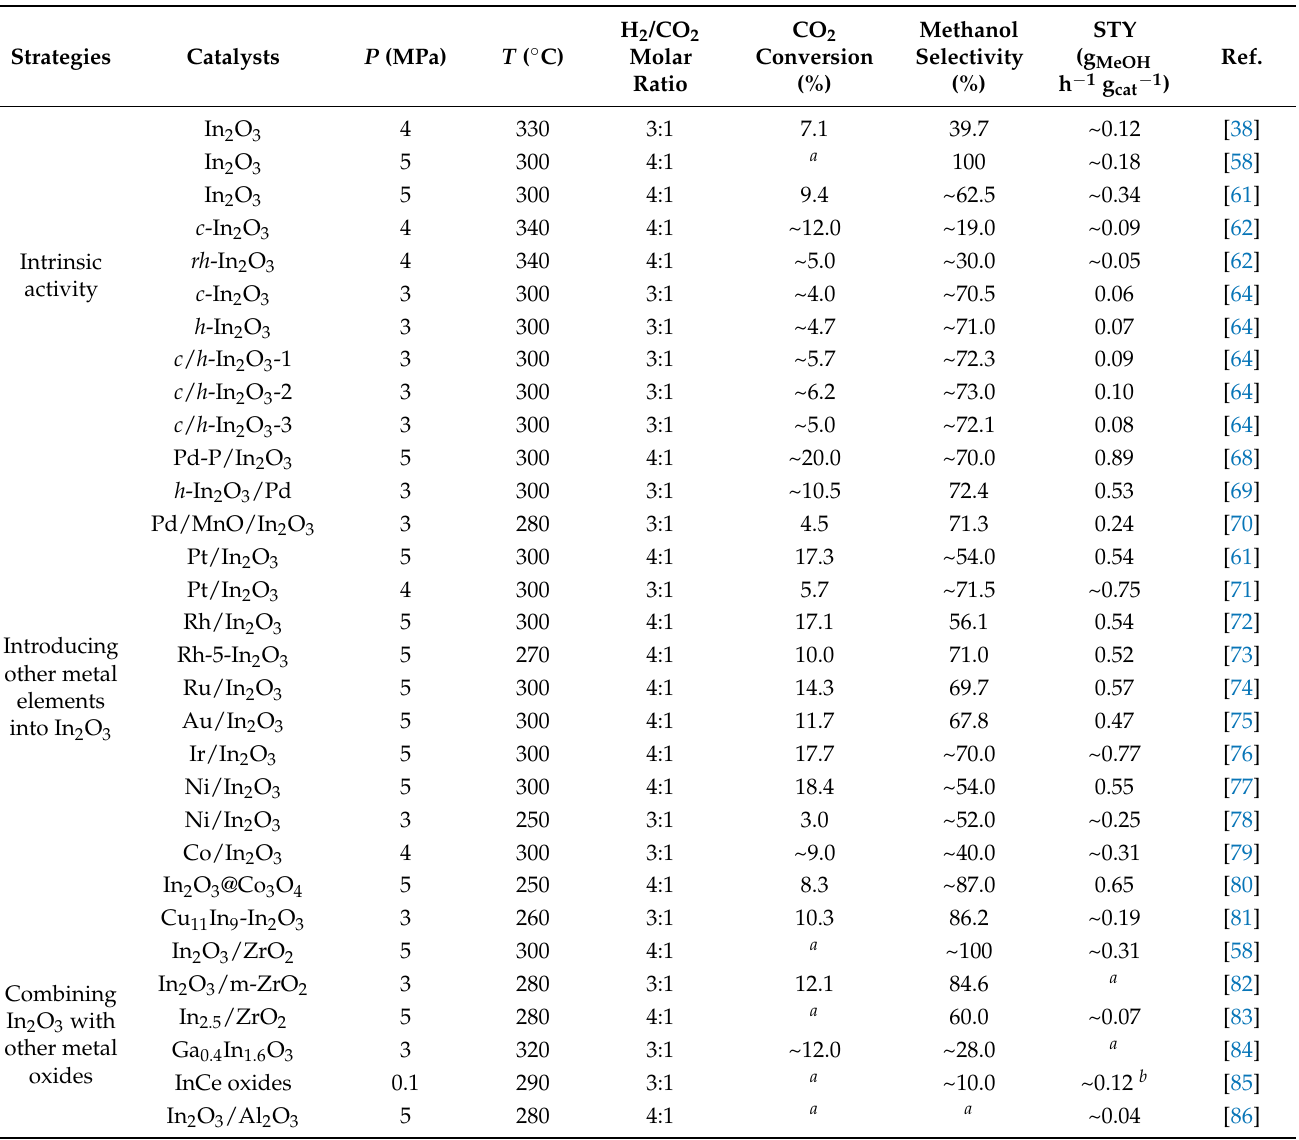
Table 1. Catalytic performance of In 2 O 3 -based catalysts in previous